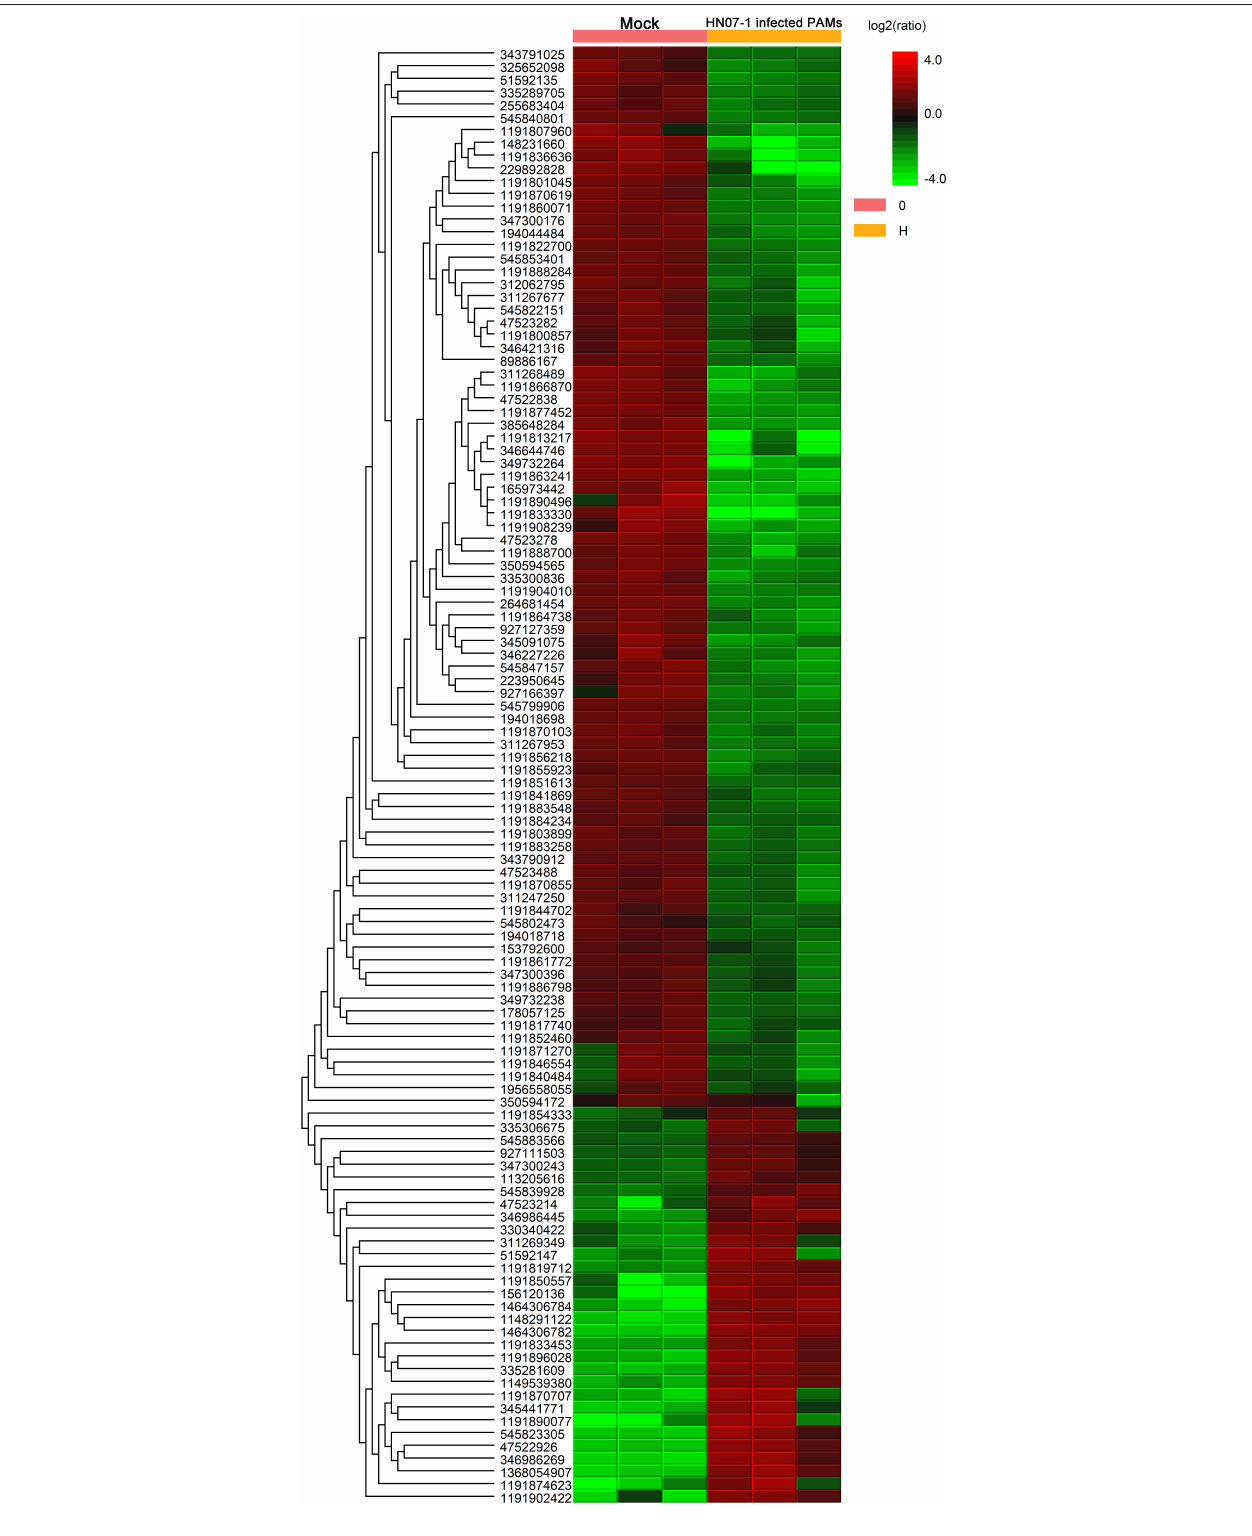
FIGURE 2 | Clustering analysis of significantly differentially expressed proteins in HP-PRRSV HN07-1-infected PAMs. Unsupervised hierarchical clustering of differentially expressed (fold change ≥ 2 and P < 0.05) proteins in HP-PRRSV HN07-1-infected PAMs. The columns represent mock cells and HP-PRRSV-HN07-1-infected PAMs for three replicate samples, while rows represent different proteins. Up-regulated and down-regulated proteins are indicated by red and green colors, respectively, with color intensity reflecting magnitudes of protein expression level changes, as shown in the legend at the upper right. More information can be found in Supplementary Table 7